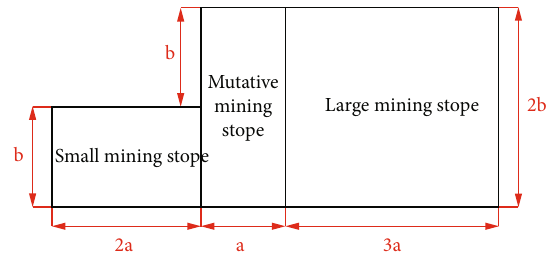
Figure 1: Zoning model of stope with variable length.